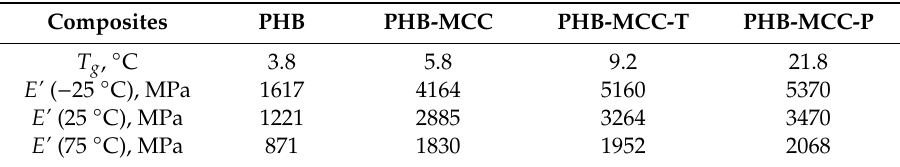
Figure 10. Storage modulus ( a ) and tan δ ( b ) vs temperature curves for PHB and composites with different treated MCC . Table 5. DMA data for PHB and composites: PHB ‐ MCC, PHB ‐ MCC ‐ T and PHB ‐ MCC ‐ P .